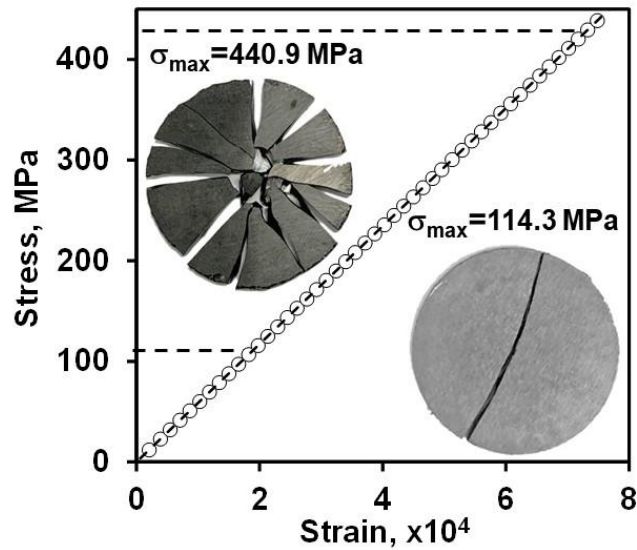
Figure 9. Biaxial stress-strain deformation plot and two photos of B 4 C samples that failed at the maximum and the minimum biaxial stress applied.